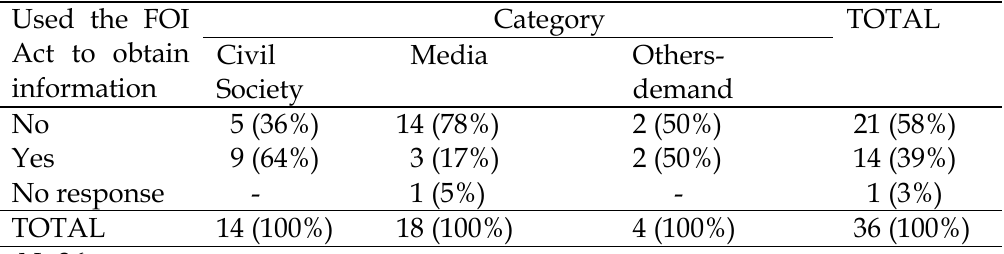
Table 4: Used the FOI Act to Obtain Information Used the